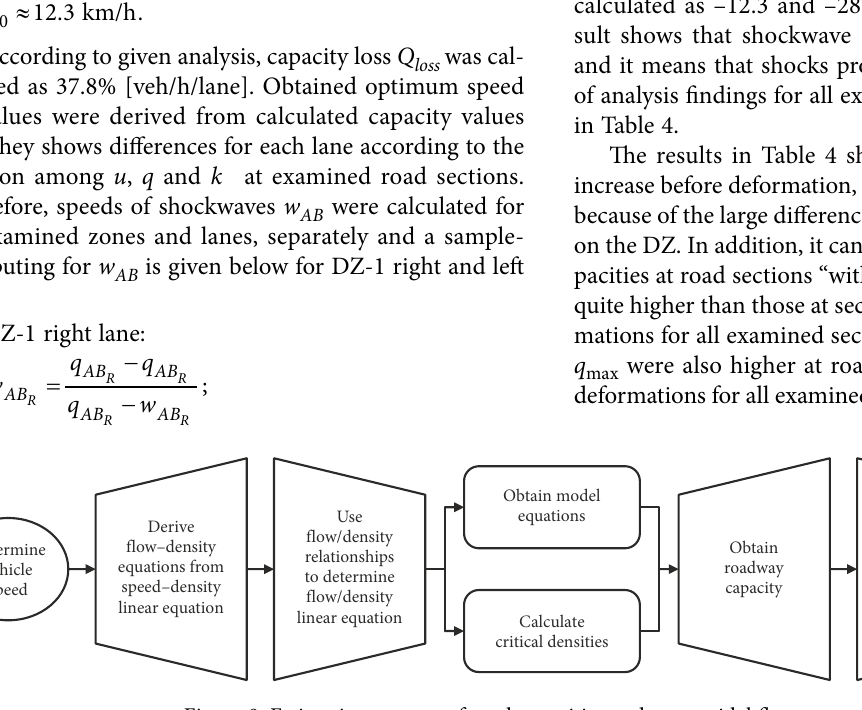
Figure 8. Estimating process of road capacities and trapezoidal flow contractions Table 4. Estimated parameters for road sections A, B and